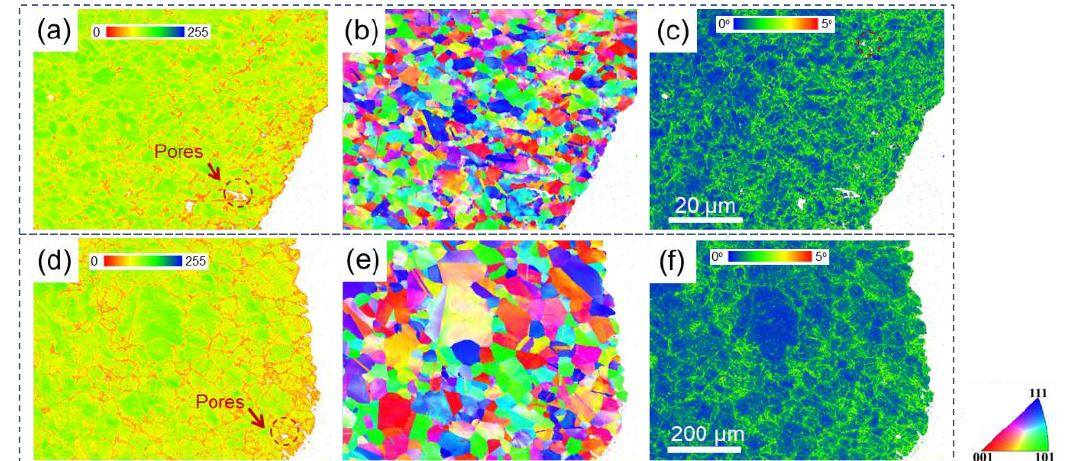
Figure 5. BC ( a , d ), IPF ( b , e ), and KAM ( c , f ) maps of SL ( a – c ) and SH ( d – f ) near fracture at 550 ◦ C. BC, IPF, and KAM maps for two specimens near fracture at 750 ◦ C are shown in Figure 6. With the deformation temperature increasing, the microstructures near fracture are quite different from those at 550 ◦ C (Figure 5). The band contrast qualities increased, while KAM values decreased for both specimens, which were tested at 750 ◦ C compared to at 550 ◦ C. However, more pores can be observed near fracture for SL at 750 ◦ C than at 550 ◦ C and the level for SH remained low, which can be seen in Figure 6d. As for the KAM maps for the two specimens at 750 ◦ C, the local misorientation is obviously lower for SL (Figure 6c) than for SH (Figure 6f). The local misorientation for SL is higher at ~5 µ m away from fracture and remained at a low level further away from fracture, compared to the undeformed SL (Figure 3c). In contrast, high local misorientations could still be observed at a distance of about 600 µ m away from fracture (see Figure 6f).